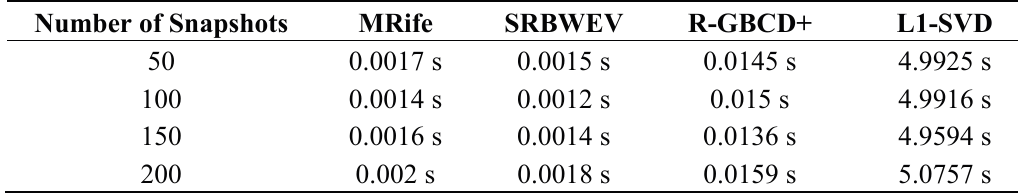
Table 1. The running time versus the number of